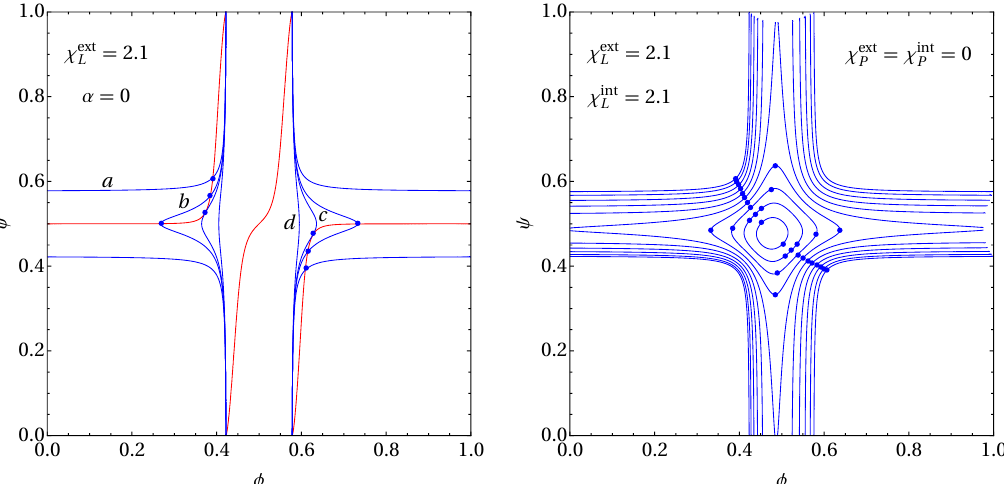
Figure 2. Left diagram: Spinodal lines (curves in blue color) and the solution of Equation (9) = 2.1 and the four different choices (the curve in red color) calculated for α = 0, χ ext L = 2.1 (spinodal labeled “ a ”), χ int = 2.045 (“ b ”), χ int = 2.027 (“ c ”), and χ int = 1.95 (“ d ”). χ int L L L L Intersections of the blue and red lines (marked by blue bullets) specify the critical point locations. = χ int = 2.1 and A tri-critical point is located on curve “c”. Right diagram: Spinodal lines at fixed χ ext L L = χ int = 0 for different α , ranging from α = 0 (the outermost spinodal) to α = 0.045 (the innermost χ ext P P spinodal) in increments of 0.005. Critical points are marked on each spinodal by blue bullets. All results on the left and right diagram are calculated for Λ =